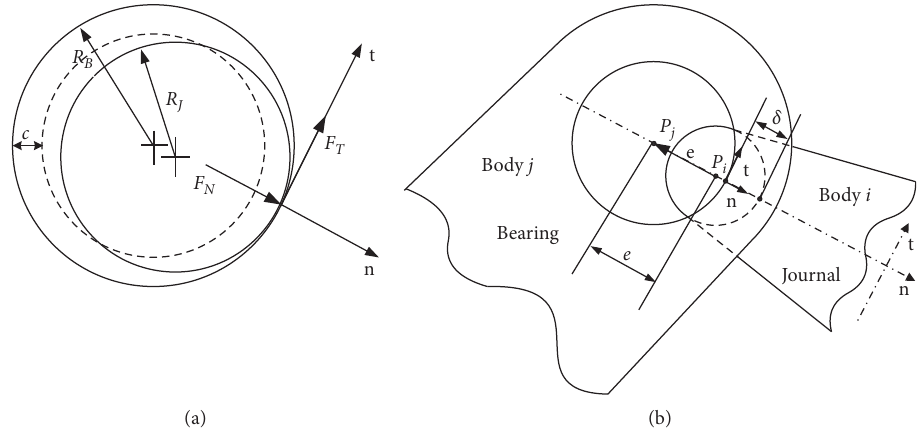
Figure 1: (a) Joint contact forces; (b) revolute joint with